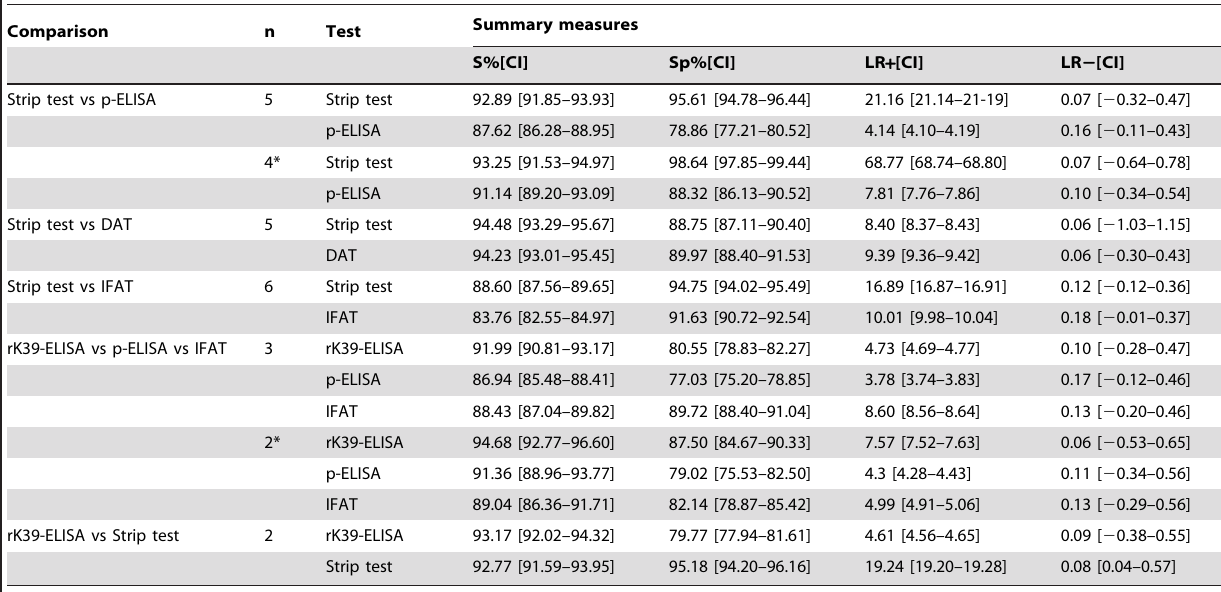
Table 1. Comparison of the sensitivity, specificity and likelihood ratio of tests.